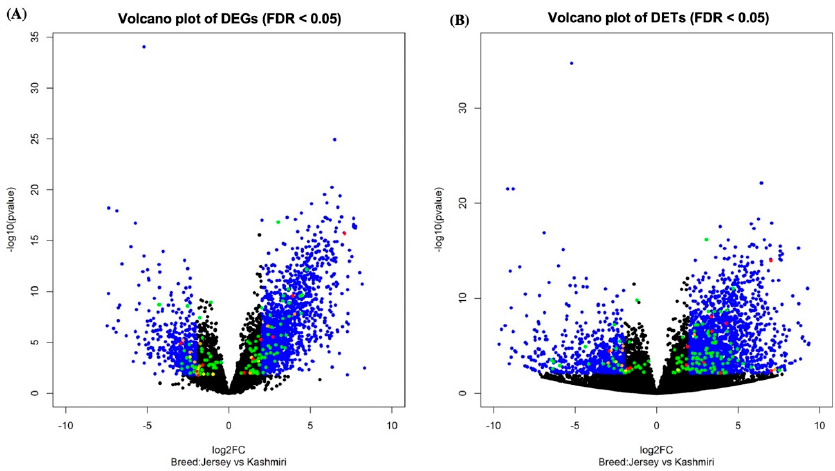
Figure 2. Differentially expressed milk-trait-associated QTL genes and transcripts in the milk tran- scriptome of Jersey and Kashmiri breeds ( A ) DEGs and ( B ) DETs. Volcano plot showing the signif- icance versus the fold change. Blue dots ( p < 0.05 and log 2 FC > 2): all Bos indicus genes; green dots ( p < 0.05): QTL genes; orange dots ( p < 0.05): bottleneck genes; yellow dots ( p < 0.05): hub genes; red dots ( p < 0.05): genes possessing hub and bottleneck features.